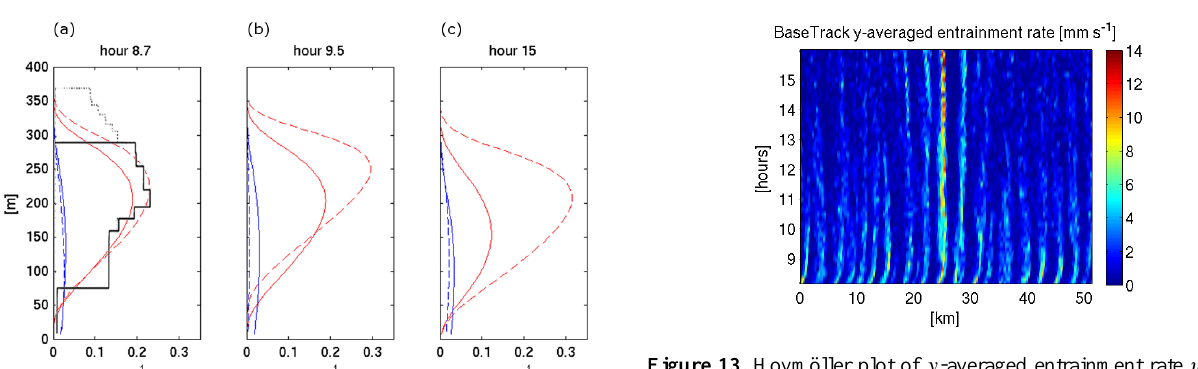
Figure 13. Hovmöller plot of y -averaged entrainment rate w e for run BaseTrack. a positive feedback that would accentuate the track.